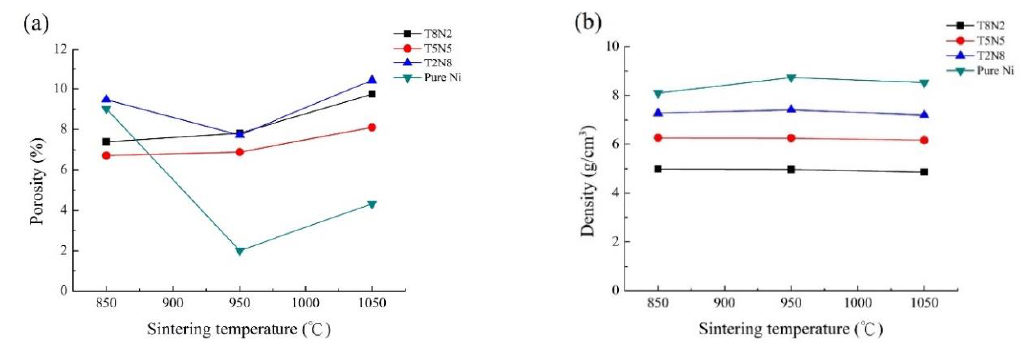
Figure 5. ( a ) The porosity and ( b ) the density of pure nickel, T2N8, T5N5, and T8N2 sintered at various temperatures.